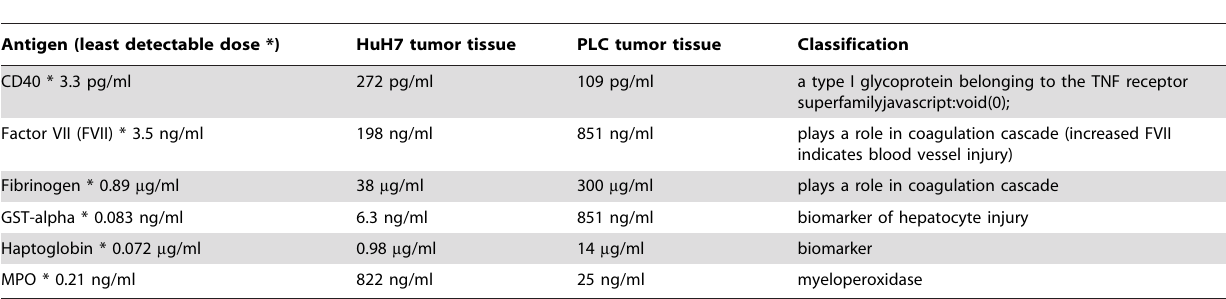
Table 3. Comparison of mouse immune-related protein antigen profiling in uninfected primary HuH7 and PLC tumors at day 20 after implantation